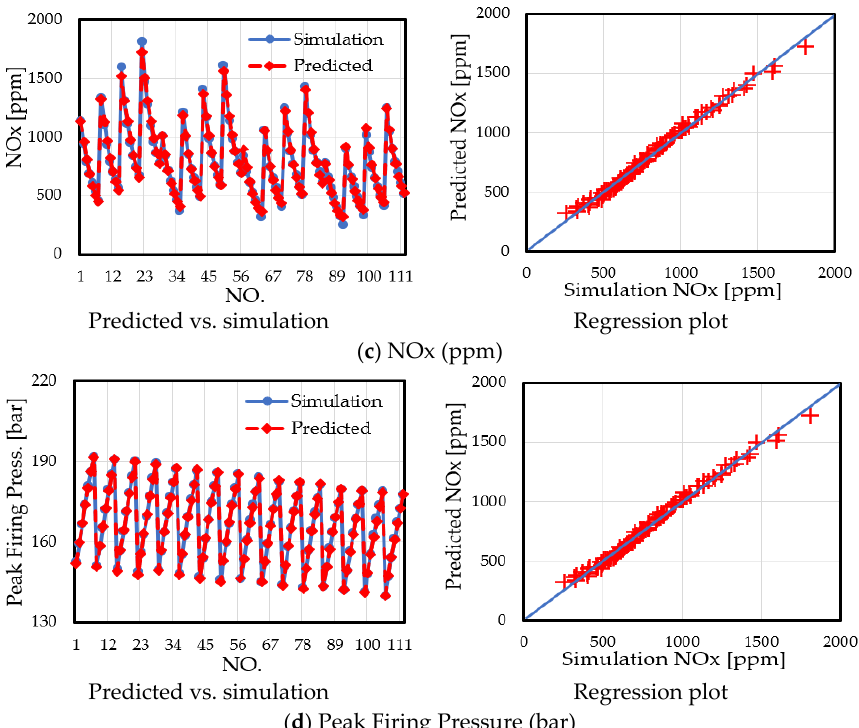
Figure 6. Comparison of predicted vs. simulation values.